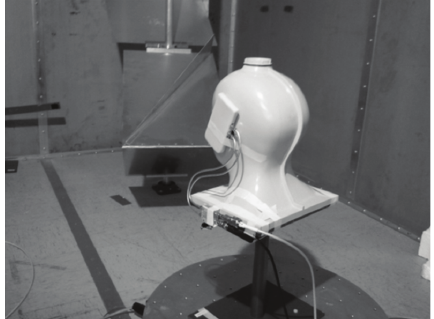
Figure 2: Measurement setup with the presence of the head phantom and the device placed in talk